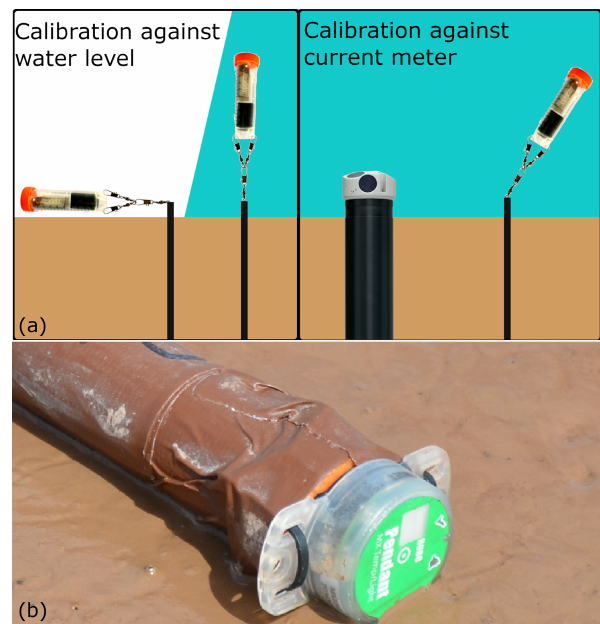
Figure 1. (a) Movements of a small bottom-mounted float (the Mini Buoy) equipped with an acceleration data logger during high and low tide. Single-axis equilibrium acceleration (i.e. tilt) of the buoy was calibrated against water-level and current-velocity data using an acoustic Doppler current meter (pictured). The Mini Buoy consists of a flat-bottom centrifuge tube which is tethered to the tidal flat us- ing fishing swivels and a metal stake. The acceleration data logger is a self-contained unit with internal battery and storage. Single-axis equilibrium acceleration (with y -axis acceleration =− 1 g when ver- tical, i.e. flooded, and 0 g when horizontal, i.e. not flooded) corre- lates with the sine of the data logger tilt relative to the horizontal plane. (b) Additional data loggers for temperature and light can be attached on top of the Mini Buoy. Further details on dimensions and logger specifications are available in the